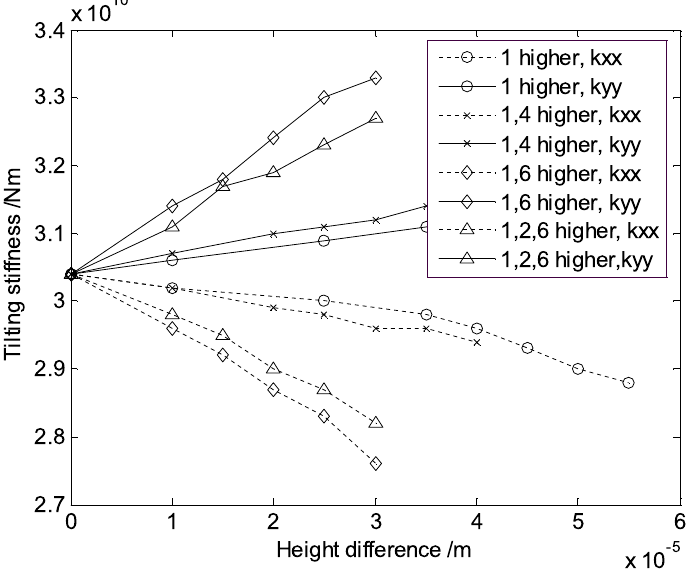
Fig. 5. Stiffness coefficients K xx and K yy versus height difference.